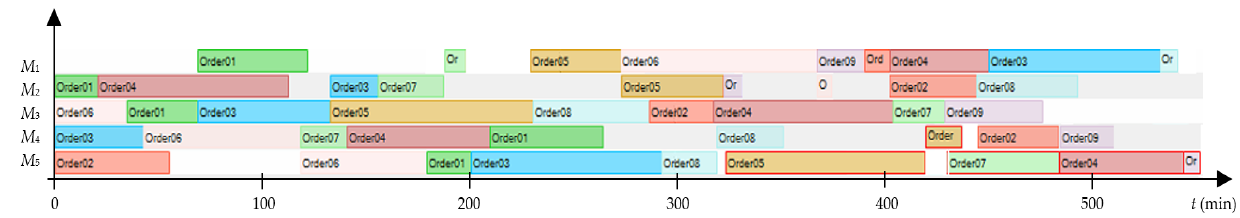
Figure 9. The Gantt chart of the 6 × 5 DJSSP with IHKA VonNeumann results obtained in Simio.